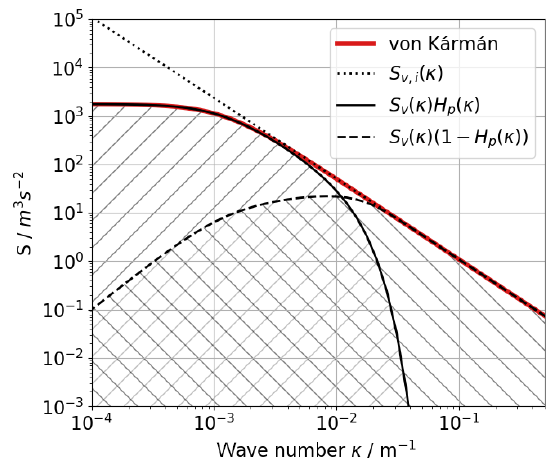
Figure 3. Theoretical spectrum for atmospheric turbulence and the contributing filtered spectra as measured by a lidar. The hatched ar- eas show the areas for the integration to calculate ˆ σ 2 v (area with forward-slanting lines, “/”) and σ 2 t (area with backward-slanting lines, “ \ ”), whereas the integration of the area under the red curve yields σ 2 v . The dotted line shows the slope of − 5 / 3 in the inertial